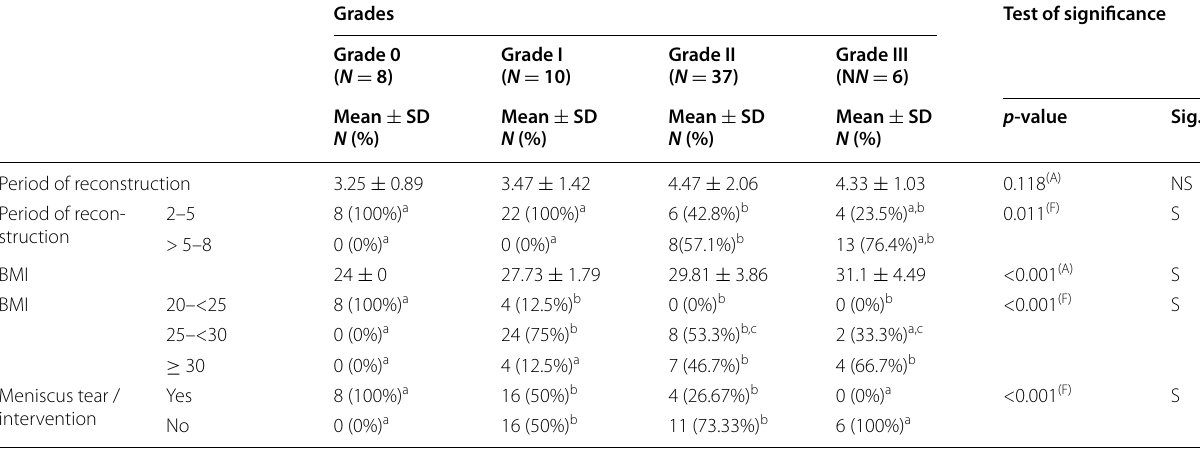
Fisher’s Exact test of significance A One Way ANOVA test of significance